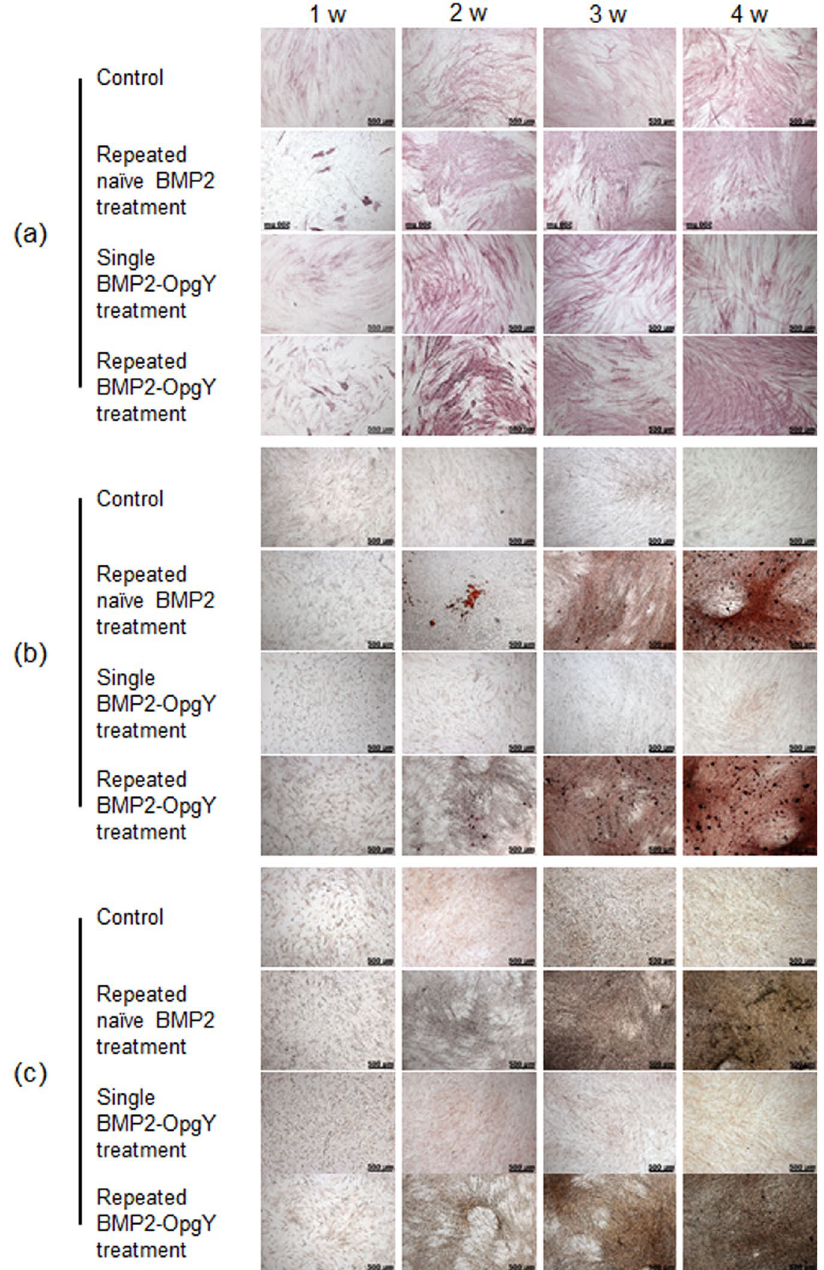
Figure 3. Staining with ( a ) alkaline phosphatase (ALP), ( b ) Alizarin Red (ARS), and ( c ) von Kossa (VK) of human periodontal ligament stem cells grown in culture medium (control), treated with a single exposure to BMP2-OpgY, and treated with repeated exposure to naïve BMP2 or BMP2-OpgY (magnification 50 × , scale bars represent 500 μ